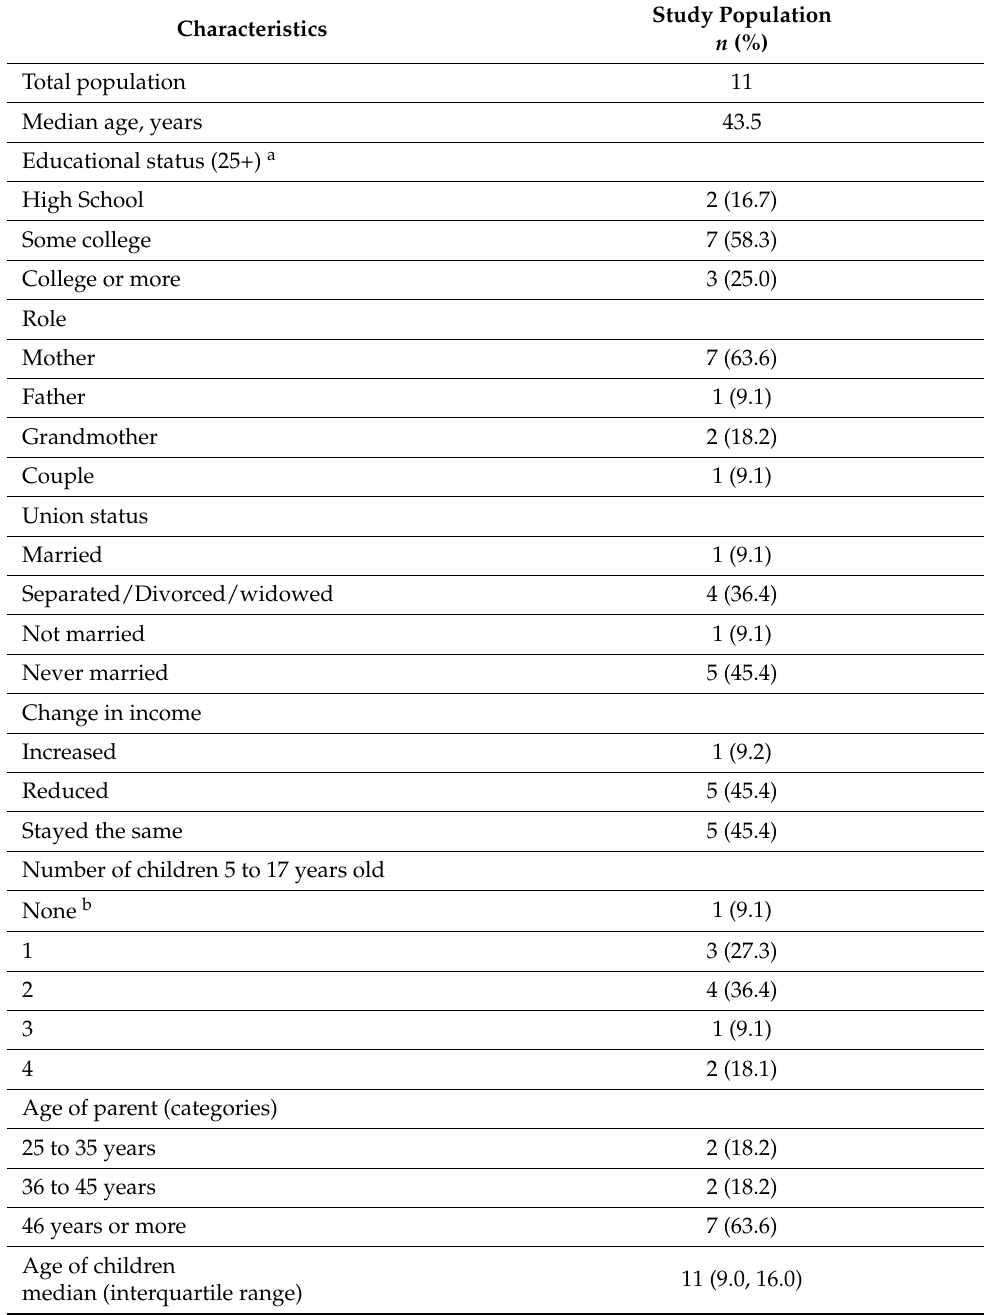
Table 1. Demographic characteristics of study